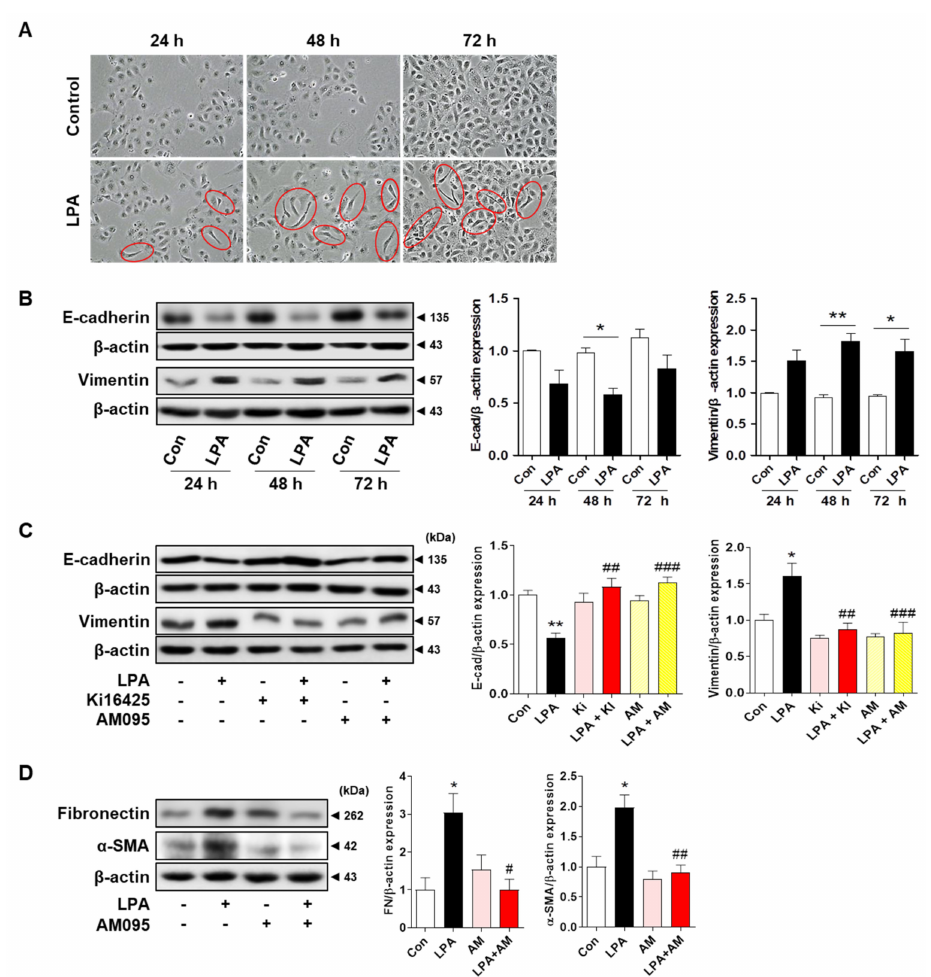
Figure 2. LPAR1/3 or LPAR1 inhibitor treatment inhibited LPA − induced changes in the expression levels of EMT markers and fibrotic factors. ( A , B ) HK-2 cells were treated with the vehicle or 20 µ M LPA for 24, 48, and 72 h. ( A ) Cellular morphology was observed using light microscopy. Original magnification, 100 × . Red circles indicate cells with an elongated spindle-shaped morphology. ( B ) Pro- tein levels of E-cadherin and vimentin were measured using Western blotting, and representative images of the blots (left) and quantification bar graphs (right) are shown. ( C , D ) HK-2 cells were treated with 20 µ M LPA in the presence or absence of 20 µ M ki16425 (Ki) or 10 µ M AM095 (AM) for 48 h. Protein levels of ( C ) E-cadherin (E-cad) and vimentin, and ( D ) fibronectin (FN) and α -smooth muscle actin ( α -SMA) were measured using Western blotting, quantified using ImageJ software, and normalized to that of β -actin. Representative images (left) and quantitative analysis bar graphs (right) are shown ( n = 3–4 independent experiments). Data are presented as the mean ± SEM. * p <